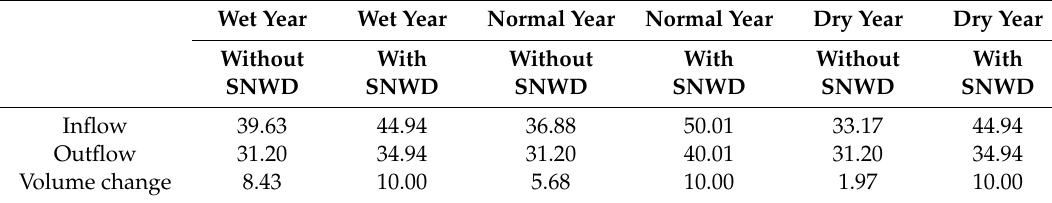
Table 4. Water volume changes of Yongnian Lake in di ff erent scenarios (Unit 10 6 m 3 ).